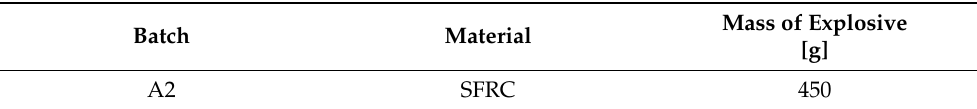
Table 3. Mass of explosives for batch